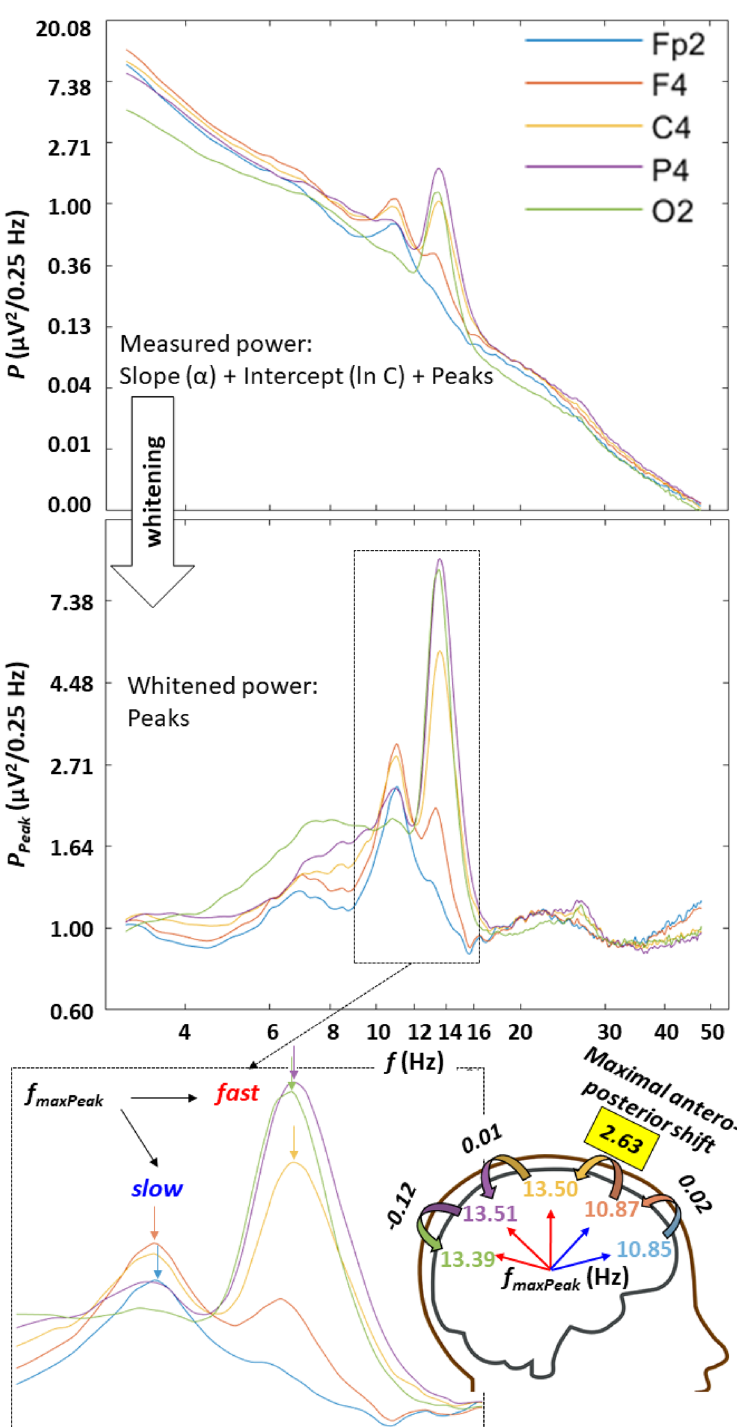
Figure 2. Examples for spectral peaks over the antero-posterior cortical axis in one of the subjects. Upper part: periodograms in the double natural logarithmic plane characterized by a combination of linear trends and spectral peaks. Middle panel: whitened power by subtracting the fitted linears: ln P − (ln C + α ln f); note the uniform baseline power (~ 1) and the spectral peaks. Lower panel: enlarged spectral peaks in the spindle frequency range, characterized by lower frequency maxima in the anterior as compared to the posterior recording locations (see colour-coded arrows); maximal antero-posterior shifts in peak frequency emerged between the frontal and central recording sites, demarcating slow-anterior and fast-posterior sleep spindle- related spectral